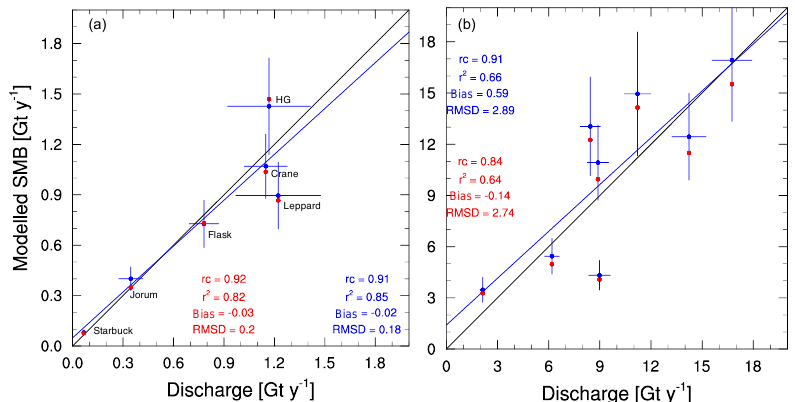
Figure 13. Modelled RACMO2.3p2/AP (blue) and RACMO2.3p1/AP (red) integrated average (1979–2016) SMB as a function of glacial discharge estimates from (a) the Larsen B embayment (Wuite et al., 2015) and (b) the George VI embayment (Hogg et al., 2017). Horizontal error bars represent the uncertainty in the discharge estimate, vertical bars the interannual variability of